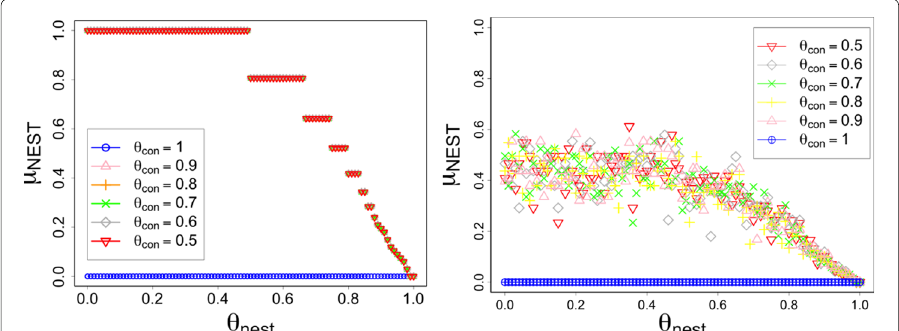
Fig. 1 Nestedness for NESTLON under variation of both exogenous parameters θ con and θ nest on a perfectly nested unipartite benchmark graph (i.e. α = 0.49). All vertices belong to a single nested component and, therefore, we choose a parameter set for which NESTLON detects all of them. In the left panel the thresholds are too rigid for θ con = 1 and θ nest ≥ 0.5. Thus, θ con < 1 and θ nest < 0.5 are reasonable detection thresholds for NESTLON. In the right panel we force NESTLON to start with a randomly selected vertex (in contrast to the highest degree) for the same benchmark graph. Although, component sizes differ independently from < 1 (about half of all vertices are detected on average due to random starting position), we infer the θ con same calibration ( θ con < 1 and θ nest < 0.5). We conclude that NESTLON works most reliable if we start with the highest degree vertex on a degree-ordered